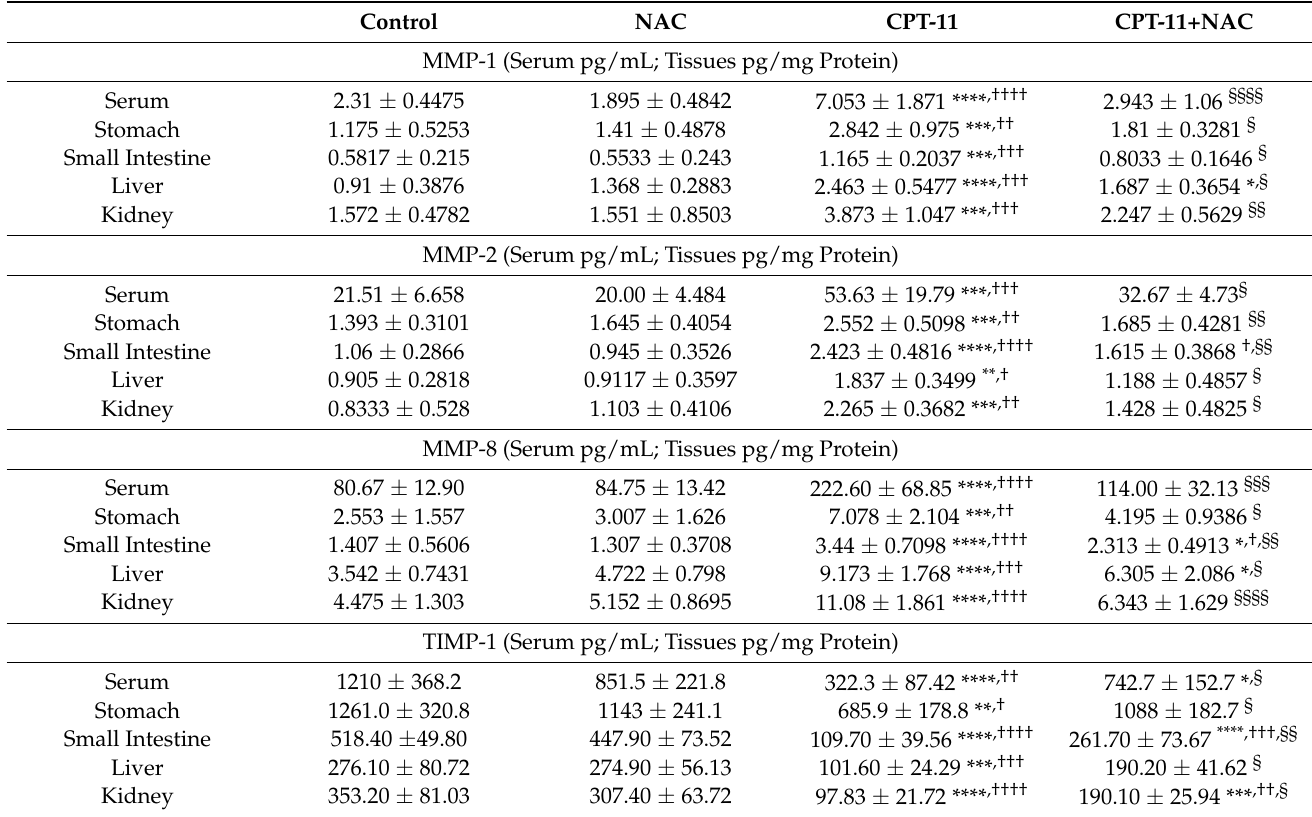
Table 2. Changes in MMPs activities and TIMP-1 levels in the sera and tissues of rats (mean ± SD).